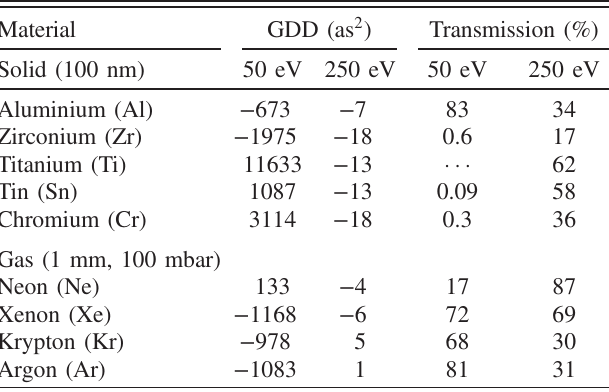
TABLE I. GDD and transmission of gases and solids for attochirp